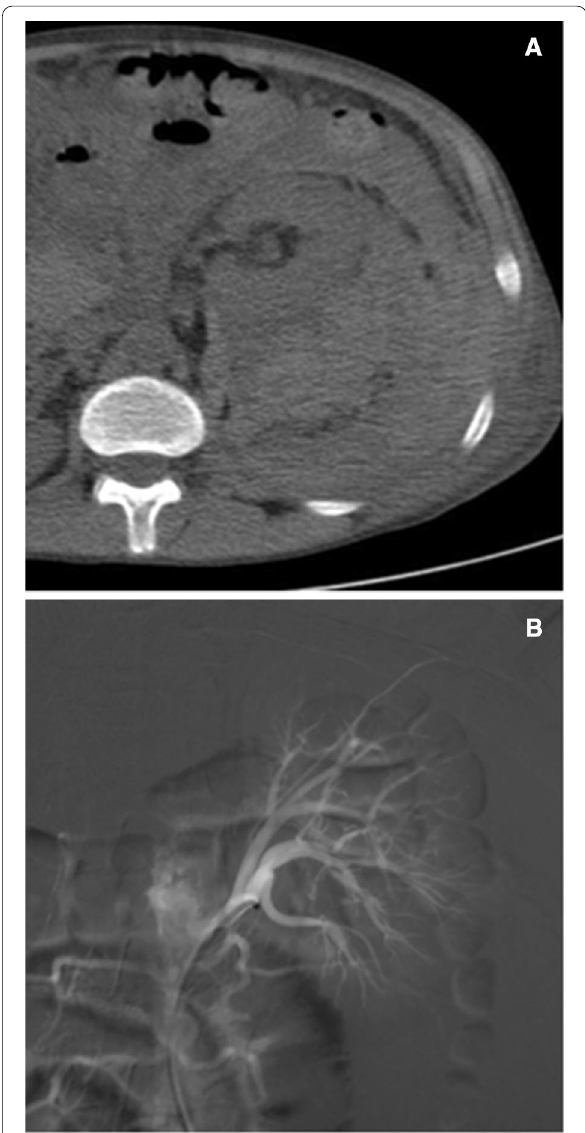
Fig. 3 Axial non‑contrast computed tomography imaging of a 42‑year‑old male patient with spontaneous haematuria showing a large posterior left perinephric haematoma displacing the kidney anteriorly ( A ). Selective left renal angiography of the same patient revealed normal intrarenal arteries with no vascular lesions ( B )